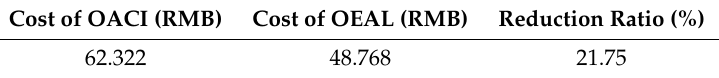
Table 4. Comparison of the cost between OEAL and OACI.